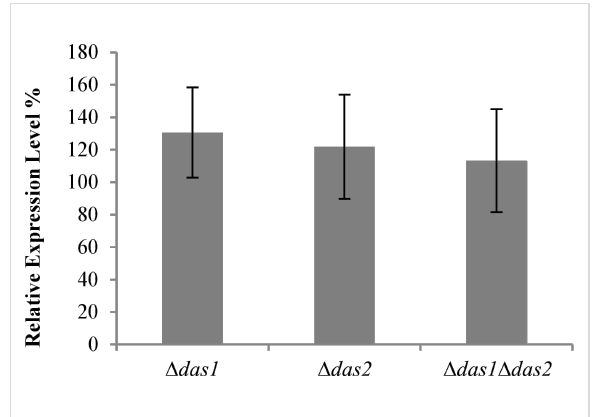
Figure 3: Relative expression levels of the green fluorescent protein (GFP) in the das knock-out strains. GFP expression obtained in the wild type P. pastoris strain indicated as relative fluorescence units per OD 600 unit was set as 100%. GFP fluorescence was measured after 70 h of methanol induction. The shown values represent mean values ± standard deviations of 40 individual